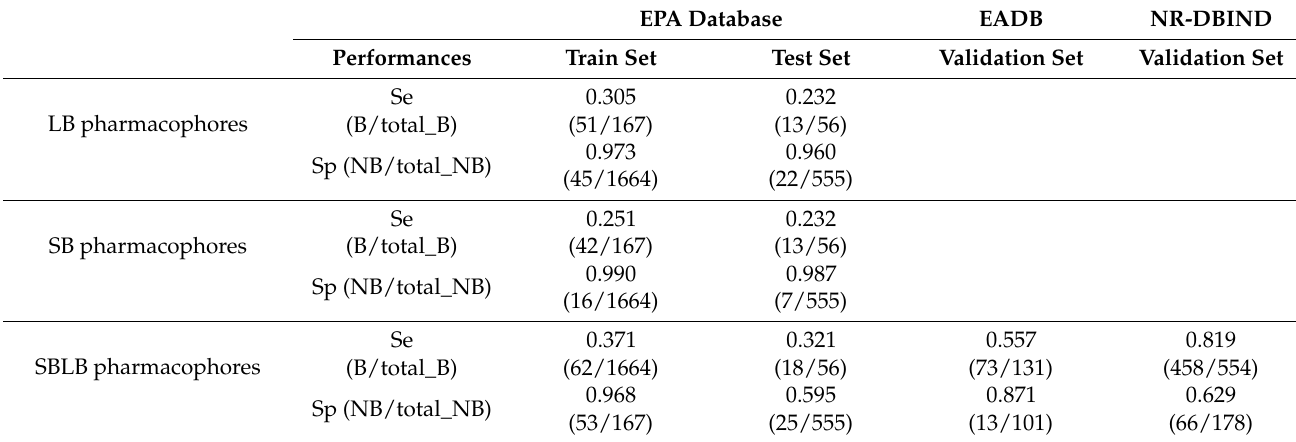
Table 4. Sensitivity (Se) and specificity (Sp) of ligand-based (LB), structure-based (SB), and combination LB and SB pharmacophores, for the training set and the test set of the EPA database, the EADB and the NRDBIND. EPA Database EADB